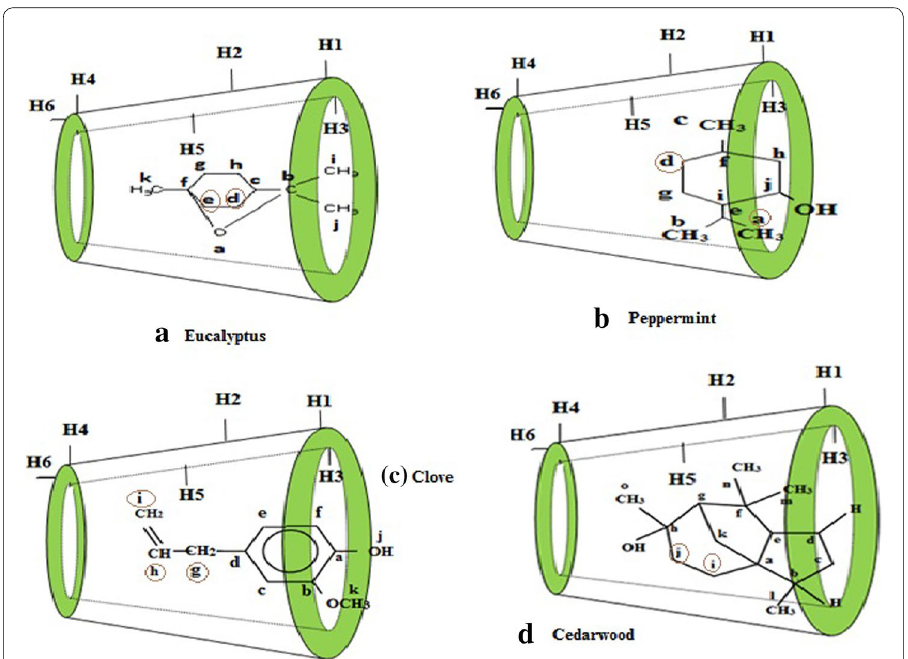
Fig. 10 Inclusion complexation of MCT β-CD with oils: a EO, b PO, c CO, d CdO (* encircled protons of oil molecules had the highest induced